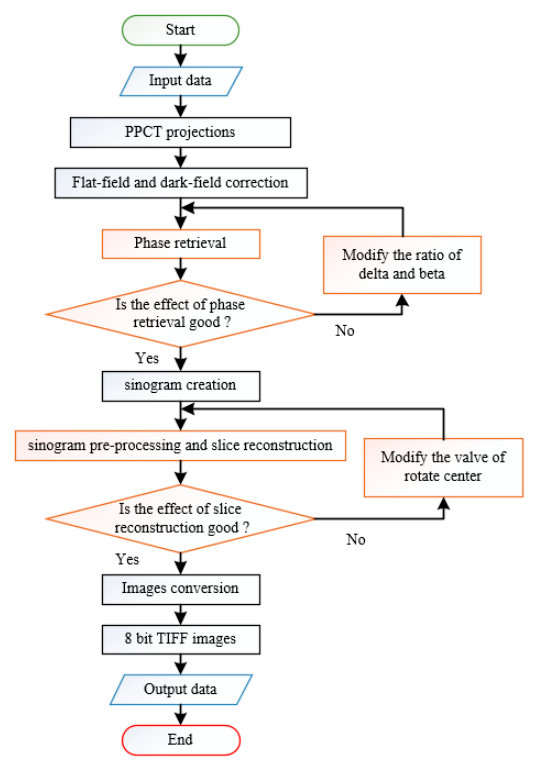
Figure 2. The flow chart of 2D image processing.